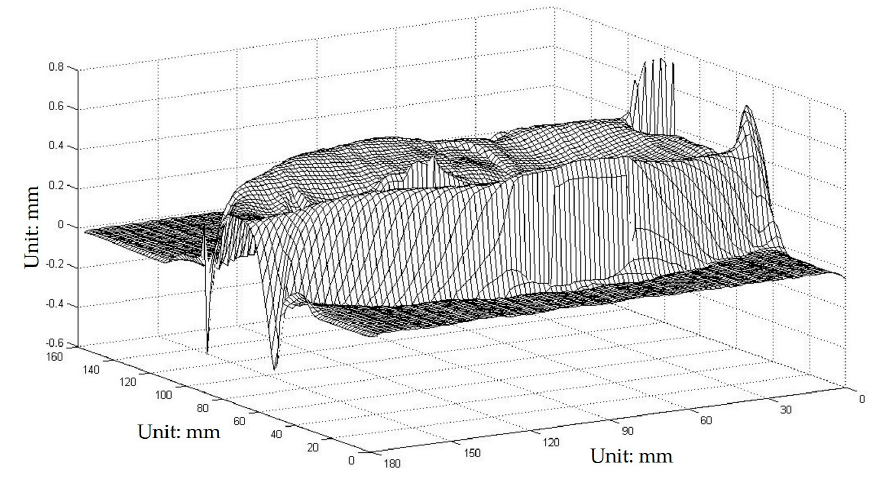
Figure 8. Errors of the proposed one-shot 3D reconstruction against traditional method.